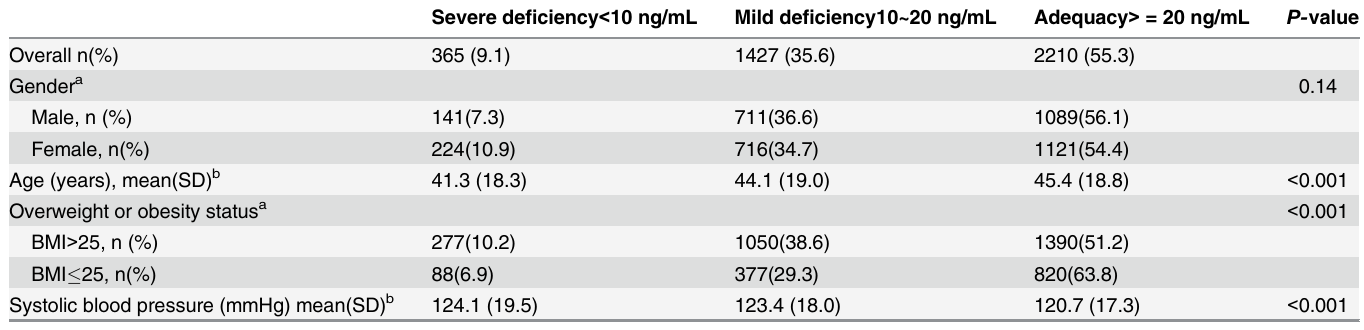
Table 3. Summary of characteristics according to vitamin D status (based on measured serum 25(OH)D concentration) among 4,002 adults of the National Health and Nutrition Examination Survey (2005 – 06), American adults who had three readings of systolic blood pressure.